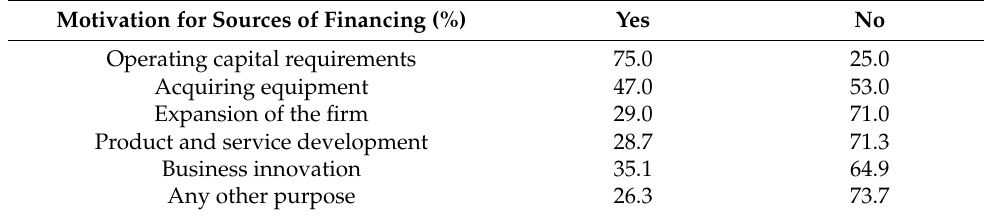
Table 2. Motivation for sources of